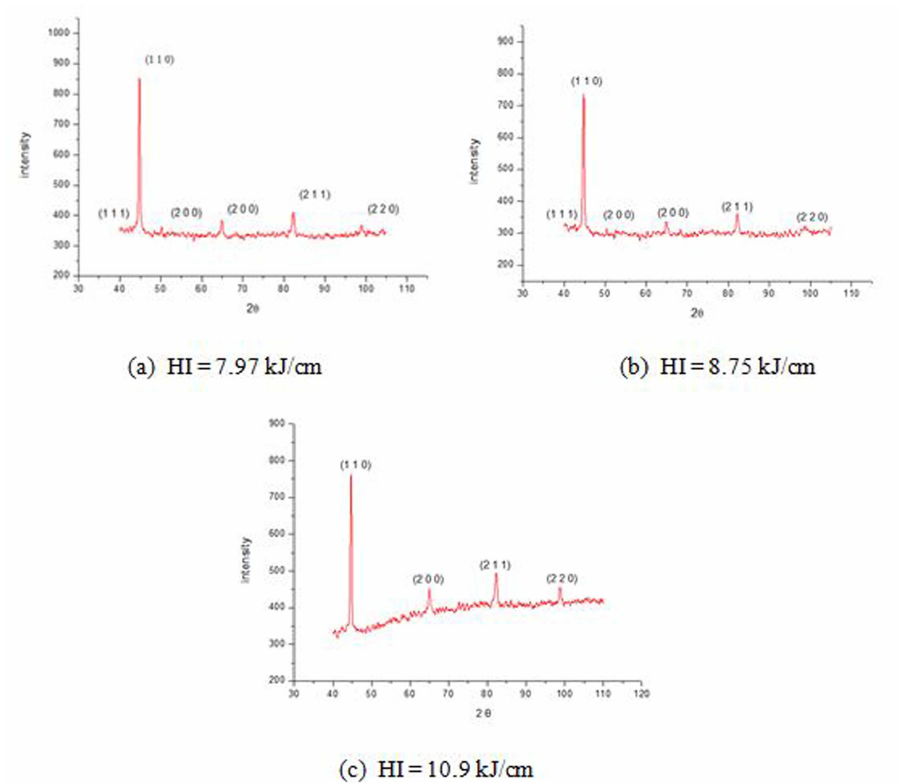
Figure 5. (a-c) XRD patterns of weld deposit under different heat